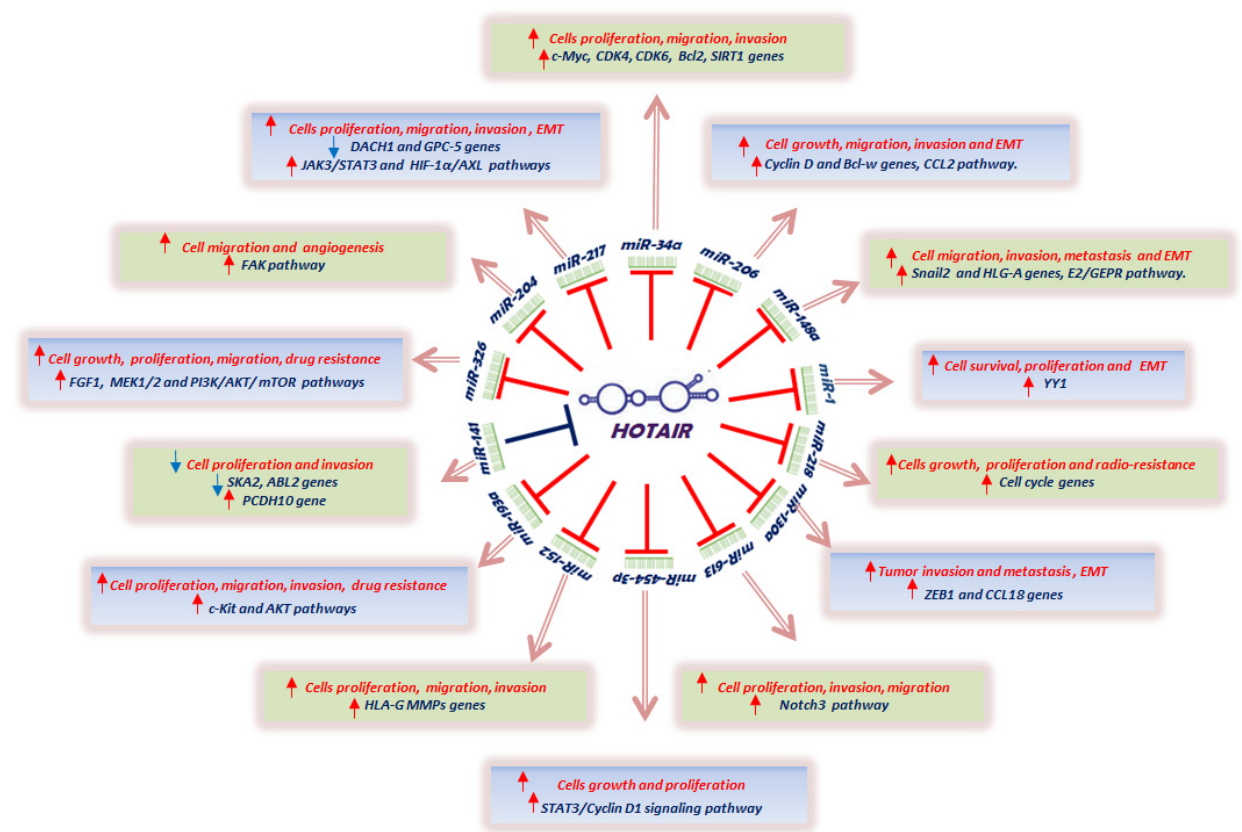
Figure 1. Schematic representation of principal functional interactions between lncRNA HOTAIR and different microRNAs. HOTAIR/miR-34a interaction promotes tumor cell proliferation, migration, and invasion by induction of the transcription factor c- Myc, the cyclin-dependent kinases CDK4 and CDK6, and anti-apoptotic proteins Bcl2 and SIRT1 in breast, gastric, pancreatic, prostate, and colon cancers; HOTAIR/miR-217 interaction modulates cell proliferation, migration, invasion, and epithelial mesenchymal transition (EMT) by downregulation of tumor suppressor genes DACH1 and GPC-5, and the activation of JAK3/STAT3 and HIF-1 α /AXL signaling pathways in lung, gastric, and kidney cancers and in osteosarcoma; HOTAIR/miR-204 interaction induces cell migration and angiogenesis by the tyrosine kinase FAK signaling pathway in breast and renal cancers; HOTAIR/MiR326 interaction promotes tumor cell growth, proliferation, migration, and chemoresistance by induction of the FGF1, MEK1/2, and PI3K/AKT/mTOR signaling pathways in lung, colon, and glioma cancers; HOTAIR/Mir-141 interaction reduces tumor cell proliferation and invasion by decreasing the cell-cycle gene SKA2 and anti-apoptotic gene ABL2, and inducing the metastasis suppressor gene PCDH10 in renal cancer and glioma; HOTAIR/Mir139a interaction promotes tumor cell proliferation, migration, invasion, metastasis, and drug resistance by induction of the receptor tyrosine kinase c-Kit and AKT signaling pathways in prostate cancer and myeloid leukemia; HOTAIR/Mir152 interaction induces tumor cell proliferation, migration, and invasion by modulation of the human leukocyte antigen G (HLA-G) and metalloproteinases expression in prostate and gastric cancer; HOTAIR/Mir454-3p interaction modulates tumor cells growth and proliferation by induction of the STAT3/cyclin D1 signaling pathway in gastric cancer and chondrosarcoma; HOTAIR/Mir613 promotes cell proliferation, invasion, and migration by modulation of the cell surface receptor notch3 signaling pathway in pancreatic cancer and retinoblastoma; HOTAIR/Mir130a increases tumor invasion and metastasis by inducing EMT and upregulates the transcription factor ZEB1 and the chemokine ligand CCL18 in ESCC and gallbladder cancers; HOTAIR/Mir218 promotes tumor cell growth, proliferation, and resistance to ionizing radiation by induction of cell cycle genes in breast and liver cancers; HOTAIR/Mir1 interaction induces cell survival, proliferation, and EMT by upregulation of the cancer metastasis gene YY1 in liver cancer and medulloblastoma; HOTAIR/Mir148a interaction increases cancer cell migration, invasion, metastasis, and EMT by inducing the Snail2 gene, Estradiol ( E2 )/G protein-coupled estrogen receptor 1 (GPER), and HLG-A axes in breast, cervical, and ESCC cancers; HOTAIR/Mir206 interaction promotes tumor growth, migration, invasion, and EMT by induction of cyclin D genes, anti-apoptotic gene Bcl-w, and chemokine ligand CCL2 in breast, ovarian, and colon cancers and medulloblastoma. For this reason, the possibility of intervening by perturbing this complex network of interactions could strongly suggest new therapeutic strategies.